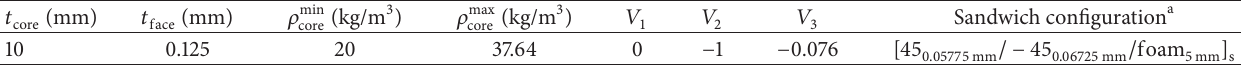
Table 4: Optimum design variables and laminate configuration.